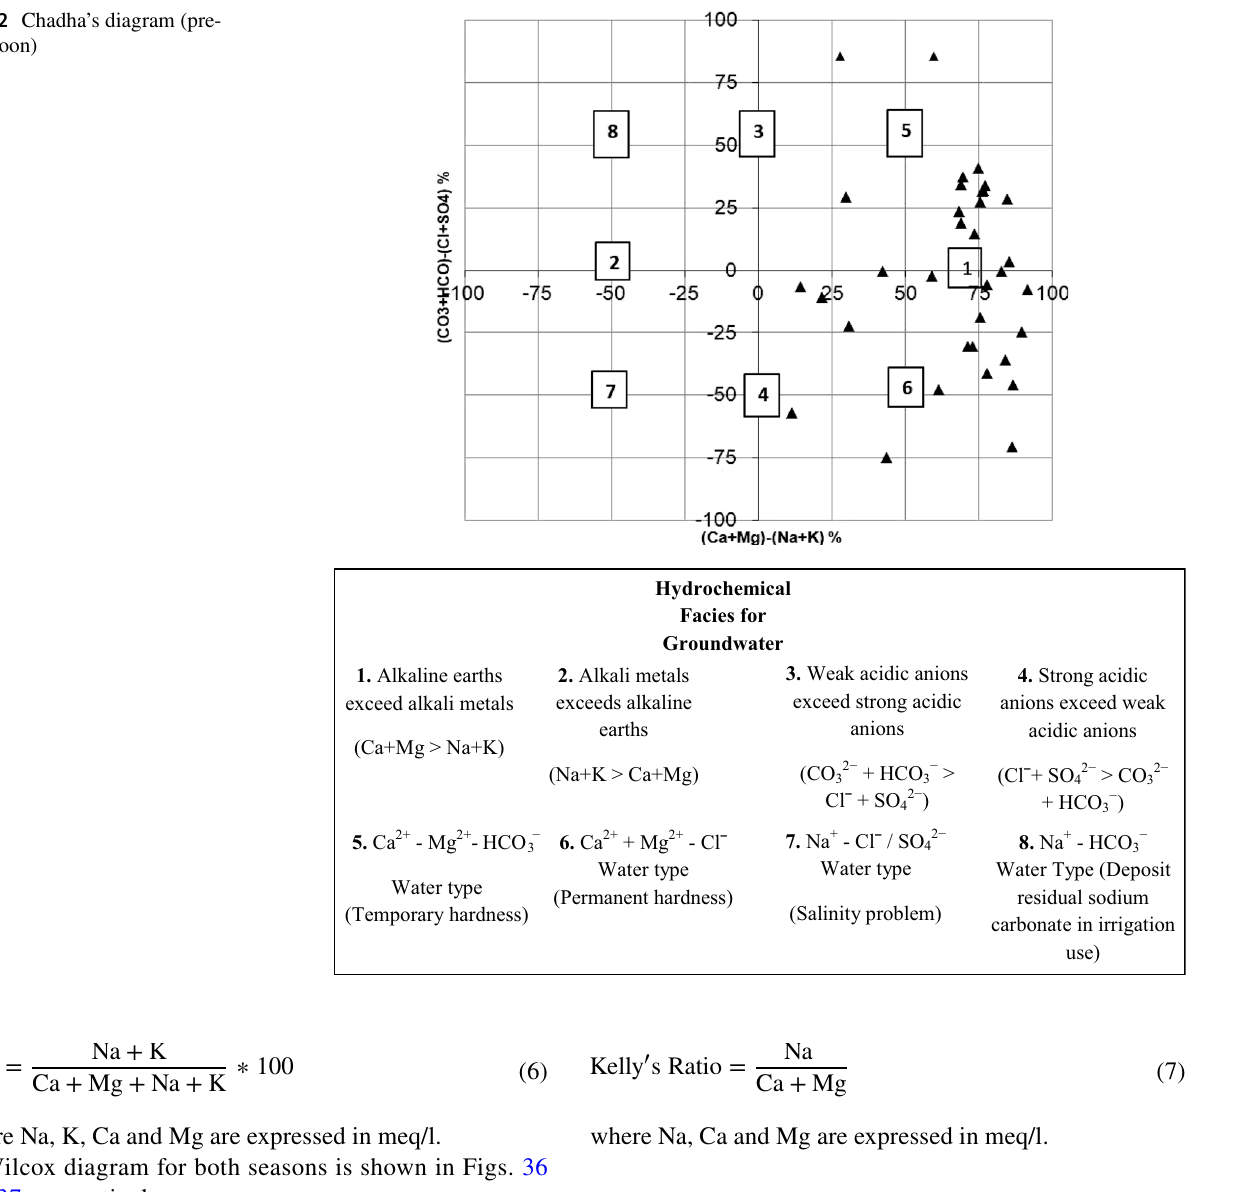
Table 4 represents the suitability classification of water for different seasons in the study area based on Kelly’s ratio. 100% of the groundwater samples of both the seasons fell into the suitable class of Kelly’s ratio values. Kelly’s ratio can be evaluated by using Eq. (7).